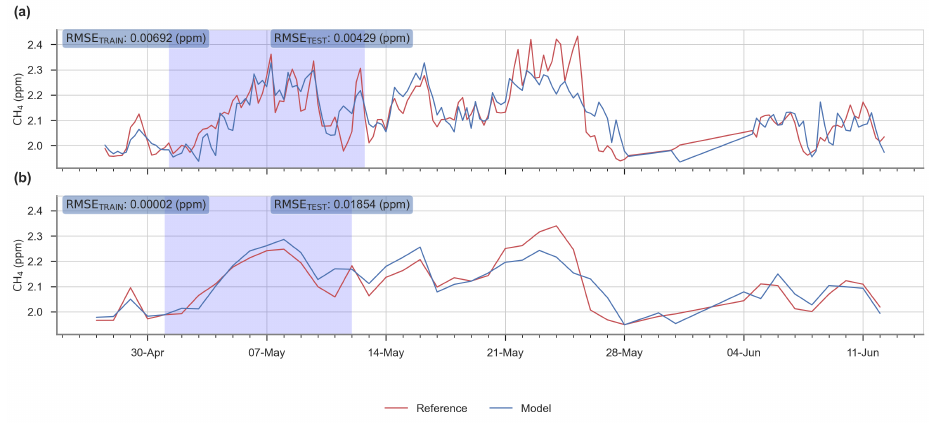
Figure A5. Output of the model for a smoothed signal of 12 h ( a ) and 24 h ( b ).